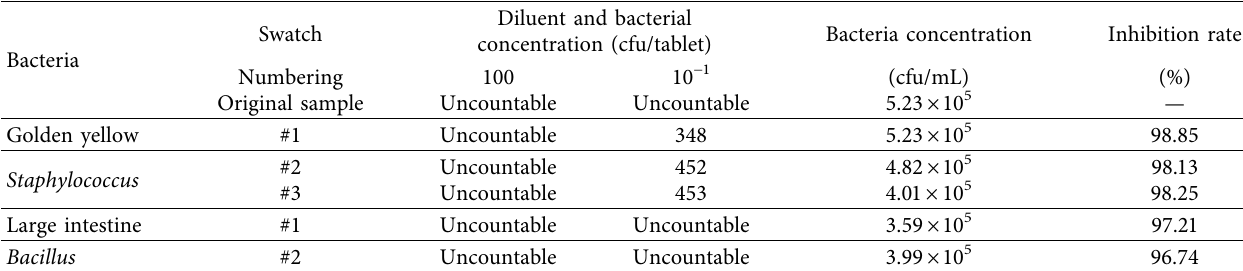
Table 4: Antibacterial effect of nano-antimite silk knitted garment fabrics on Staphylococcus aureus . The average bacteriostatic rate and range of different action time (%) Average number of colonies and range of positive control group (cfu/tablet)